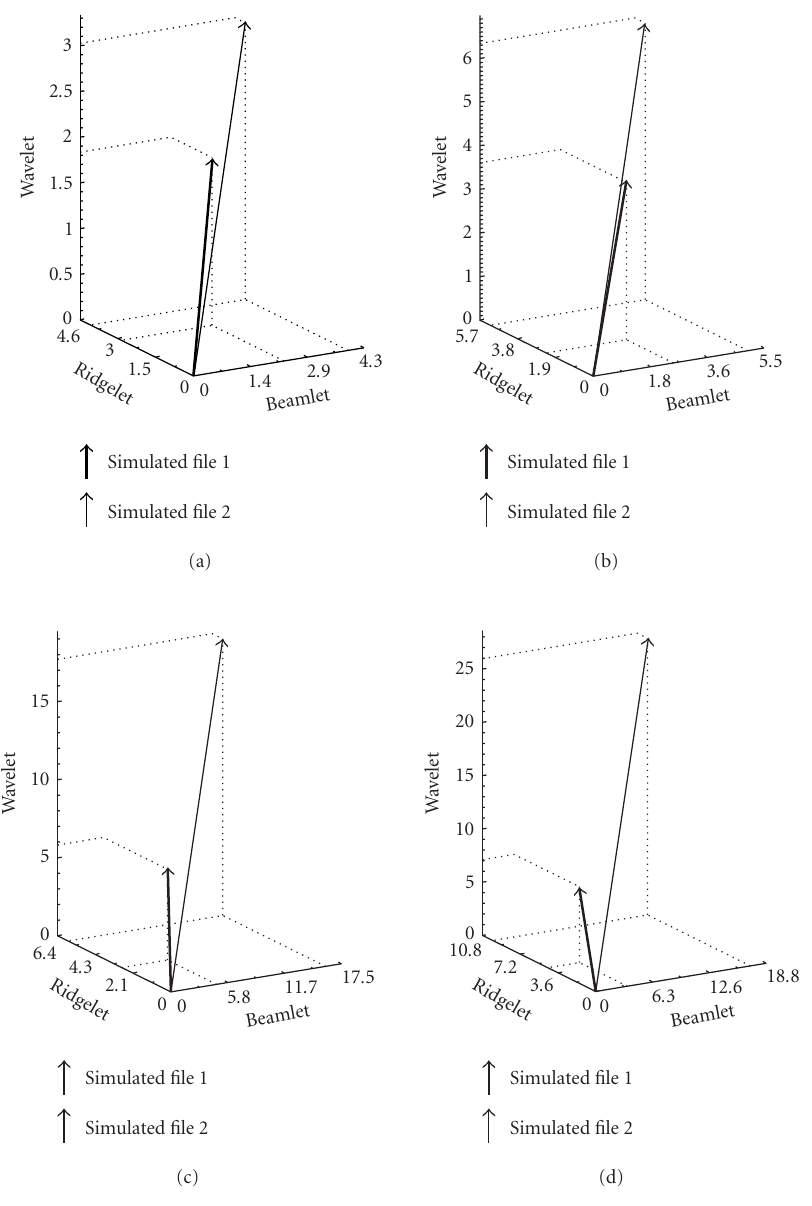
Figure 13: Skewness and kurtosis for the two simulated data sets: (a) skewness, scale 1, (b) skewness, scale 2, (c) kurtosis, scale 1, and (d) kurtosis, scale